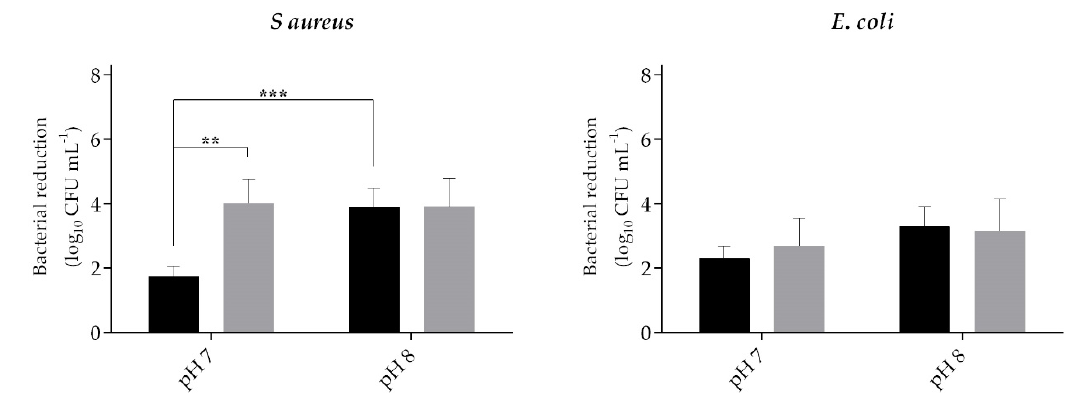
Figure 3. S. aureus and Escherichia coli CFU reduction after exposing a bacterial suspension for 5 min to 0.02-mM CTAB alone (black columns) or in combination with 1 mM of cinnamaldehyde (grey columns) when two different pH, pH 7 or pH 8, were used in the formulation. Values are mean ± SD. The statistical significance is presented (** p < 0.01 and *** p < 0.001).